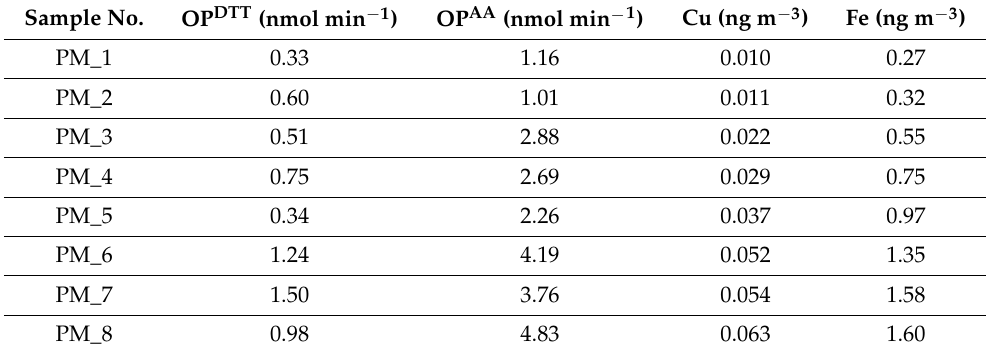
Table 3. Oxidative potential and chemical composition of real-word PM 2.5 samples: concentration of two metals (Cu, Fe) and DTT and AA consumption rate. Sample